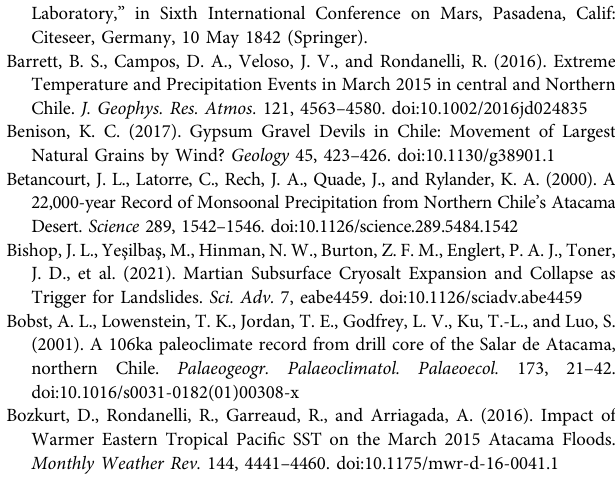
Supplementary Figure S1 | Pro fi le across the western Andean front. (A) Shaded DEM. (B) Map. (C) Satelliteimage. (D) Pro fi lealonggreenlinein (A,B,C) fromwestto east. Maps and cross section were created in Cartalytics (www.cltix.com); aerial imagery and topo map are downloaded from the Lea fl et open-source library (www. cltix.com). Supplementary Figure S2 | Spectra of gypsum samples from Salar de Pajonales. (A) X-ray diffractogram showing gypsum and calcite peaks. (B) Raman spectra with gypsum and anhydrite bands labeled. (C) IR spectra with gypsum and anhydrite bands